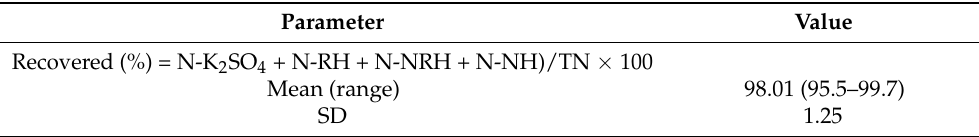
Table 3. Comparison of the aggregated nitrogen content of fractions separated from